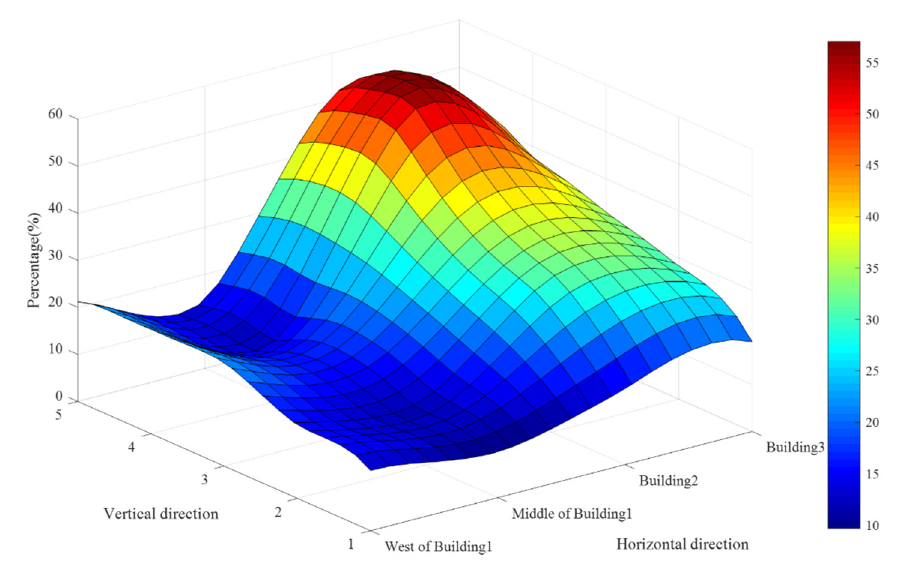
Figure 10. Airflow velocity variation trend in winter.